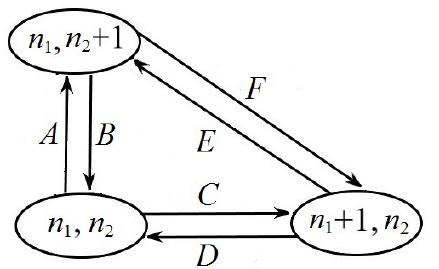
Figure 4. Digraph Ψ ( n 1 , n 2 ) representing transition intensities in the network G